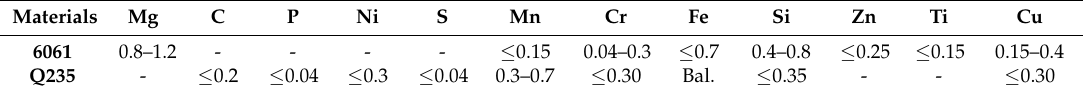
Table 1. Nominal chemical composition of 6061 alloys and Q235 steels (wt